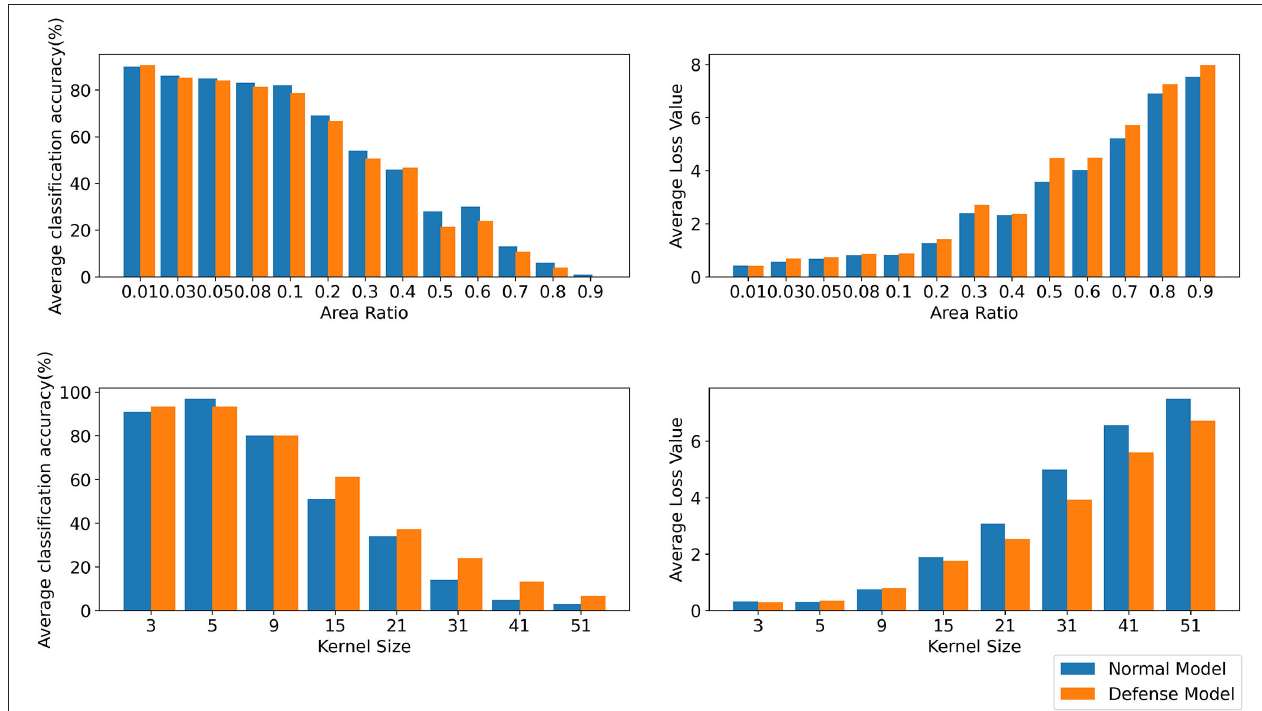
FIGURE 1 | The first line shows the average classification accuracy (%) and average loss value under normal model and defense model with different area ratios by random erasing. The second line shows the average classification accuracy (%) and average loss value under normal model and defense model with different kernel sizes by Gaussian blur. The results are averaged over 1,000